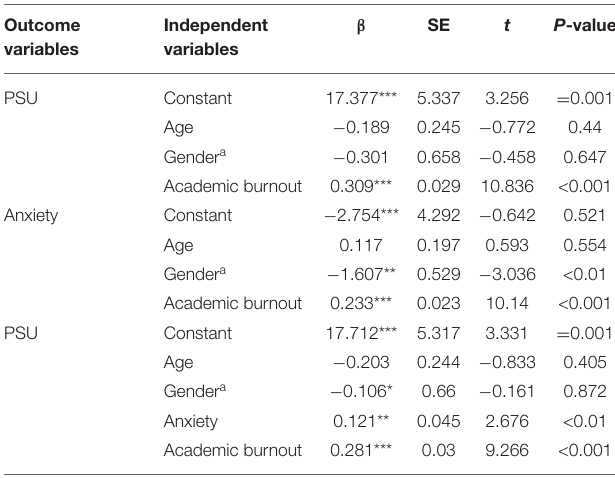
TABLE 2 | Mediation analysis.